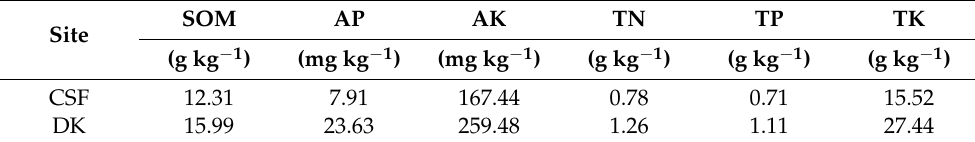
Table 1. Soil chemical properties of the 0–20 cm top soil.